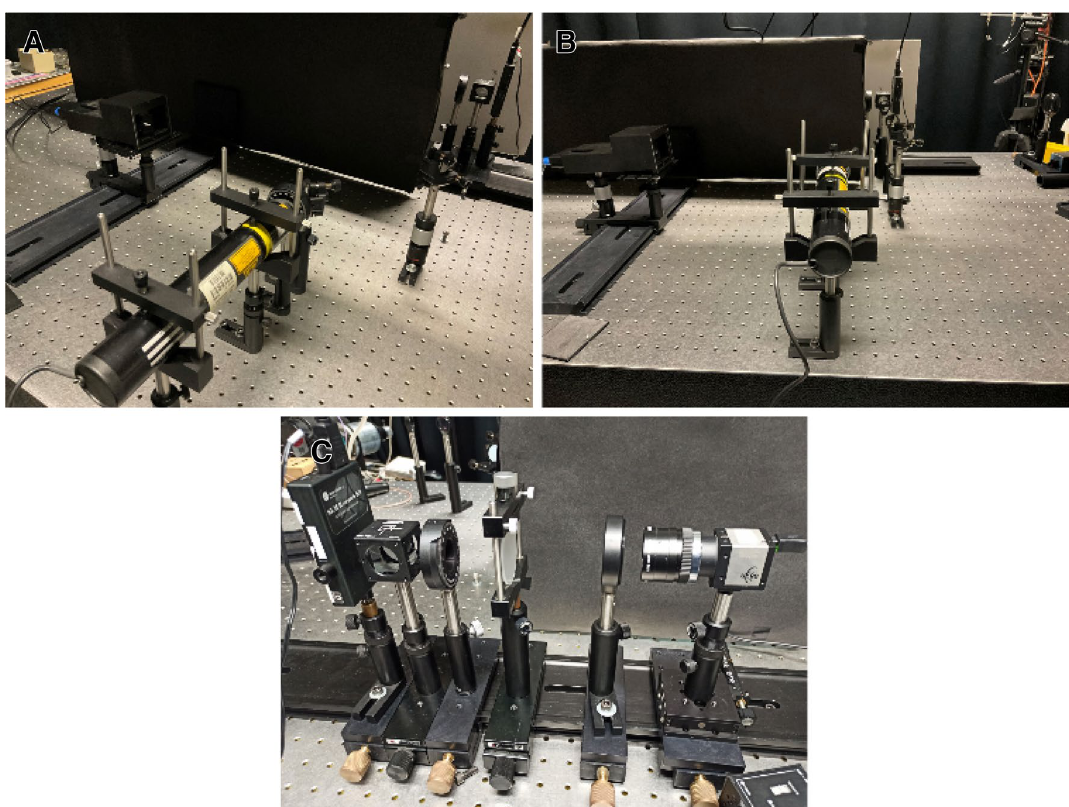
Figure 7. ( A ) and ( B ) Show the imaging setup of the imaging with multiple vortex modes and their corresponding Gaussian modes, respectively. ( C ) Shows the SLM displaying the digits dataset numbers 63 and the image acquisition setup.